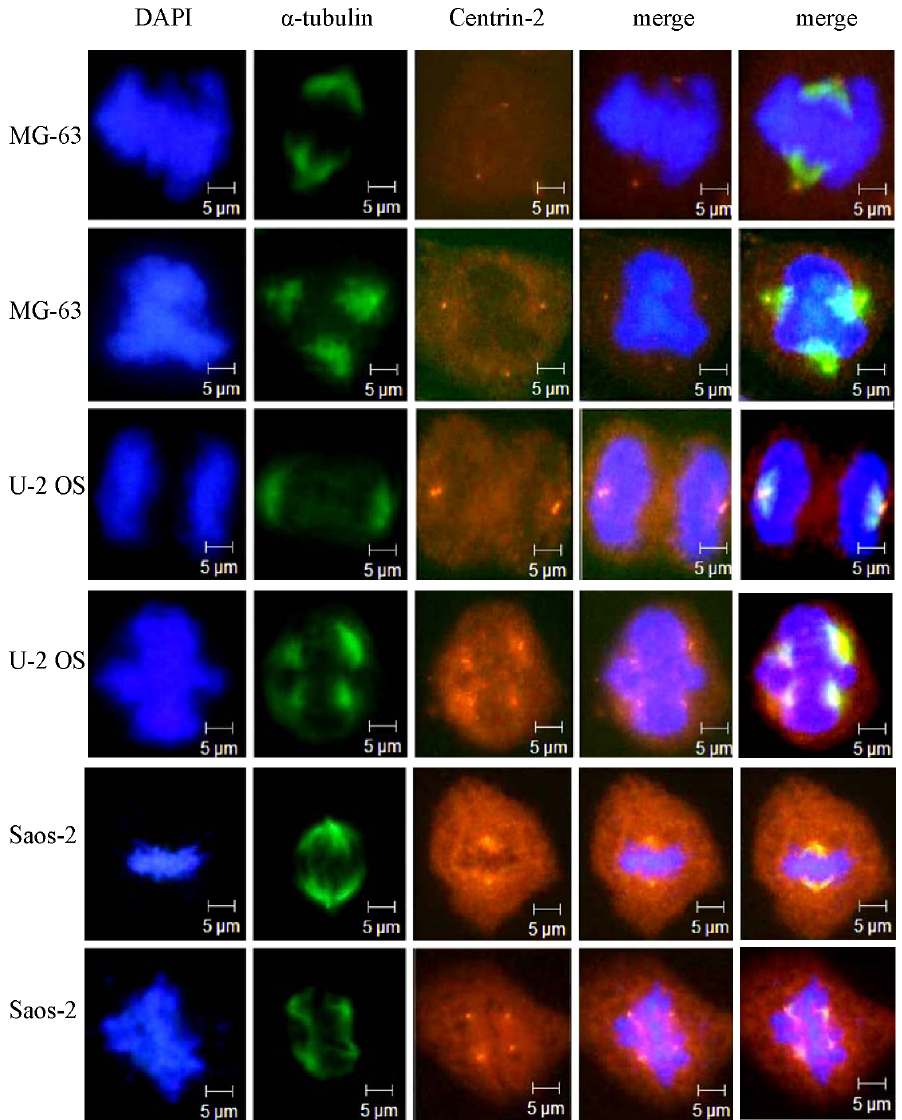
Figure 7. Centrosome status in human osteosarcoma cell lines MG-63, U-2 OS and Saos-2. MG-63 (line 1 and 2), U-2 OS (line 3 and 4), Saos-2 (line 5 and 6) cells are stained using immunofluorescence technique. Nuclei are shown in blue, microtubules in green and centrosome in red. The results indicate that multipolar spindles exist in both simulated microgravity and control groups, and centrosomes appear at each pole.